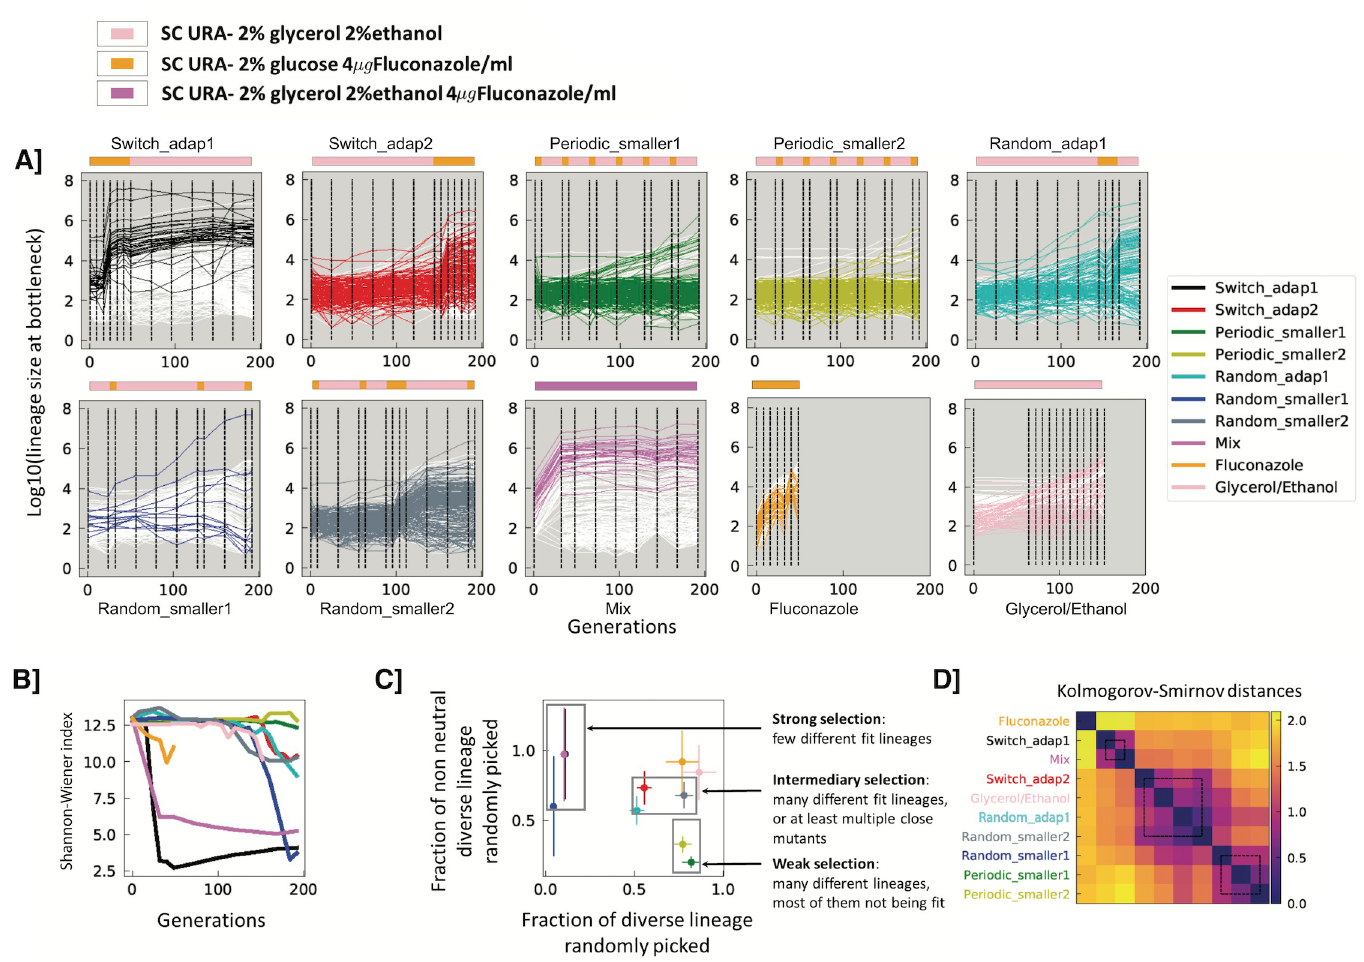
Fig 2. A] Lineage tracking data for a subsample of 300 lineages for each experiment over the course of 192 generations . Colored lines correspond to lineages for which single colonies were later isolated; white lines correspond to a randomly selected set lineages which were not sampled for fitness remeasurement. Dashed lines represent sampled time points. Environments are indicated by the color strips above each graph, with colors as in Fig 1. B] Shannon-Wiener index, calculated using frequencies for all lineages in each experiment. C] Strength of selection. 336 lineages were randomly picked from each experiment at generation 192, and we determined the fraction that were non-neutral (y-axis) and how many unique barcodes there were, out of 336 (x-axis). Error bars indicate error based on counting statistics. D] Similarity of experimental conditions . Kolmogorov Smirnov distances were calculated between all the experimental conditions based on the fitness remeasurement data (see Methods for details). The distance matrix was hierarchically